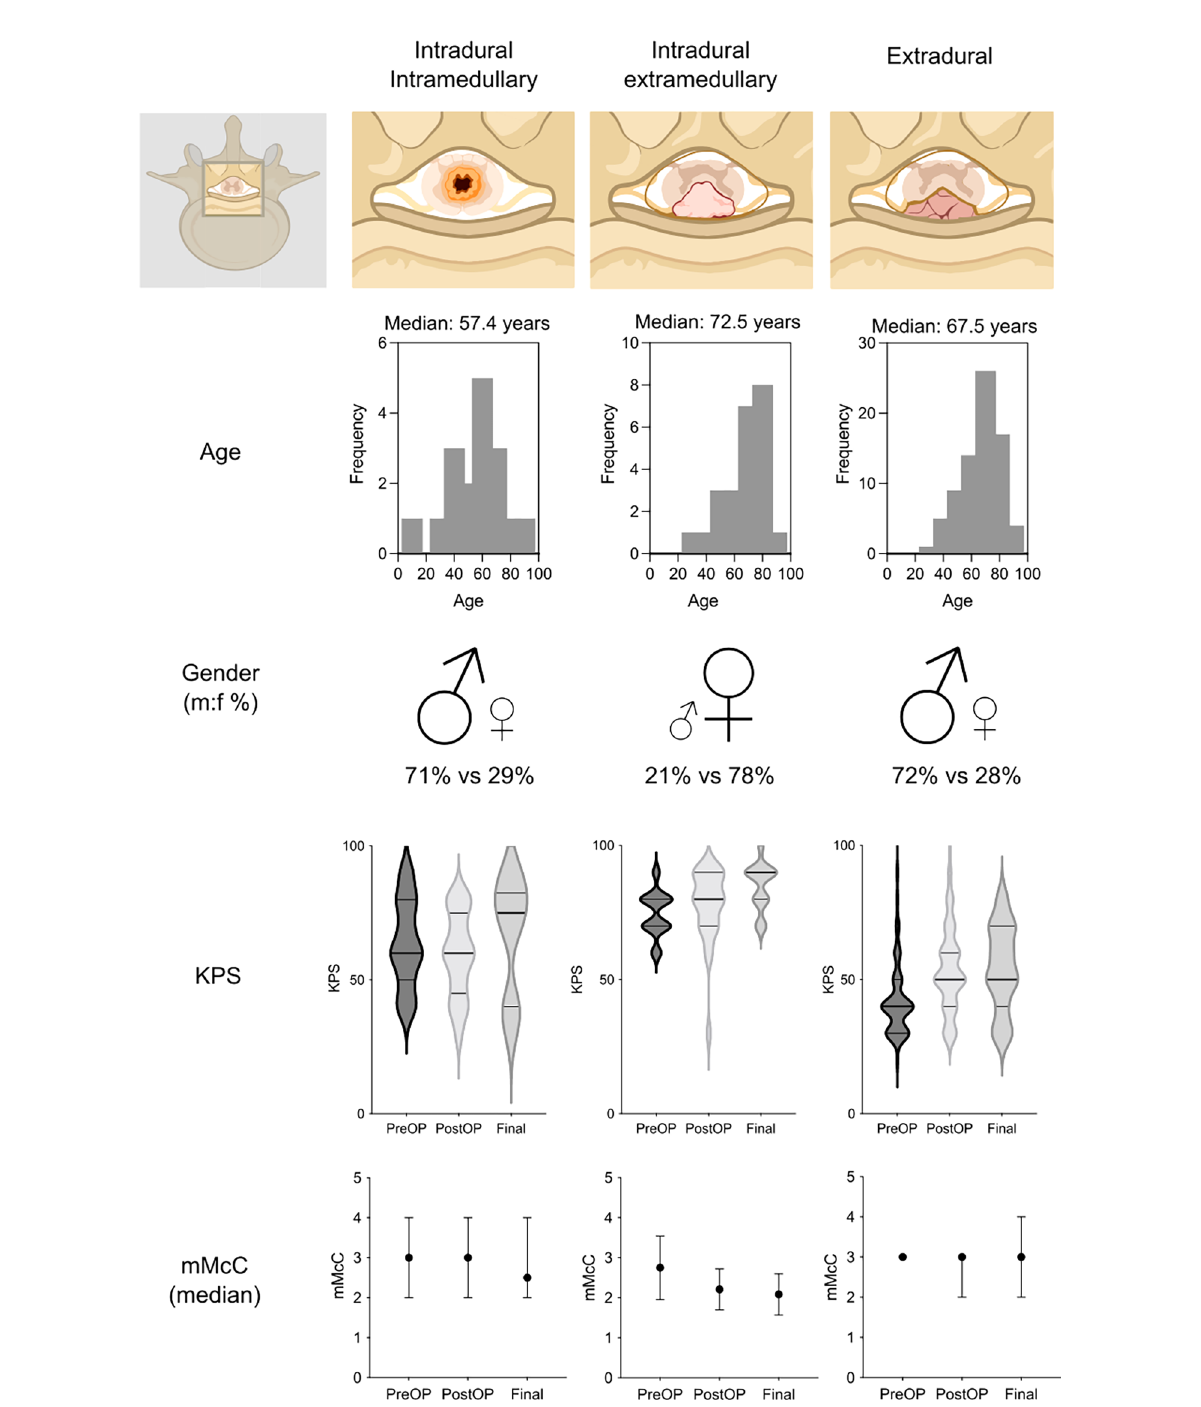
FIGURE 1 Schematic comparison of patient characteristics and their functional outcome at admission vs. discharge or fi nal follow-up in patients with intramedullary, intradural extramedullary and extradural tumors. KPS, Karnofsky Performance Scale; mMcC, modi fi ed McCormick Disability Scale Score. Parts of the fi gure were created with